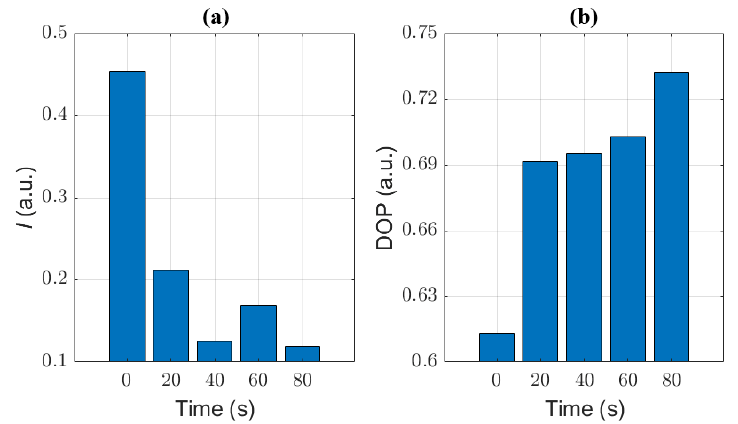
Figure 8. The mean of different samples with different ST times ( a ) I ; ( b ) DOP.